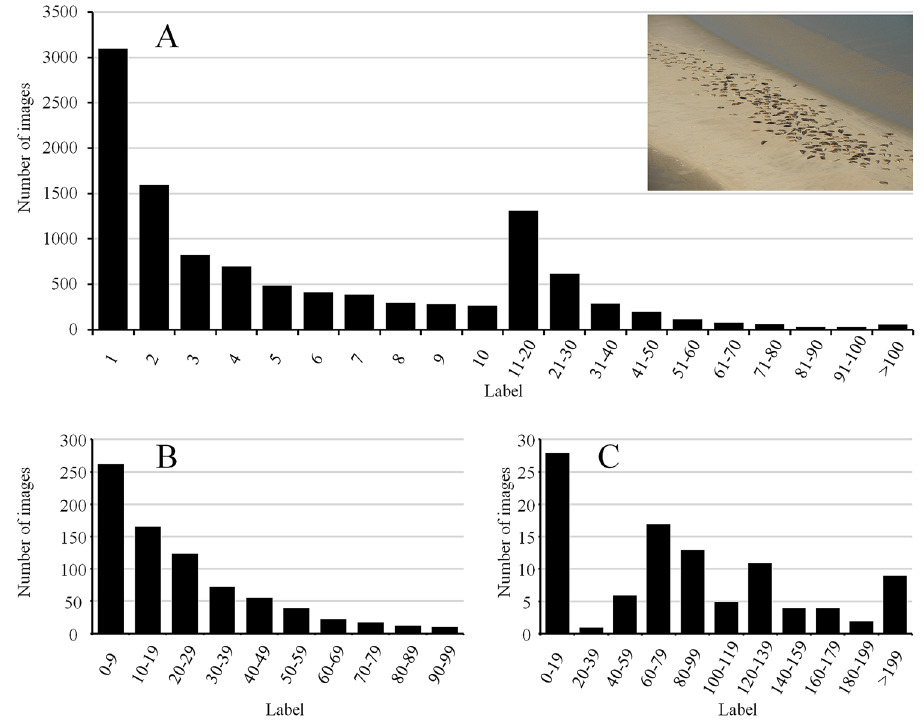
Figure 7. Distribution of the labels (i.e., number of seals) in ( A ) the seal main dataset ( n = 11,087 ), ( B ) ‘seal subset 1’ ( n = 787 ) and ( C ) ‘seal subset 2’ ( n = 100